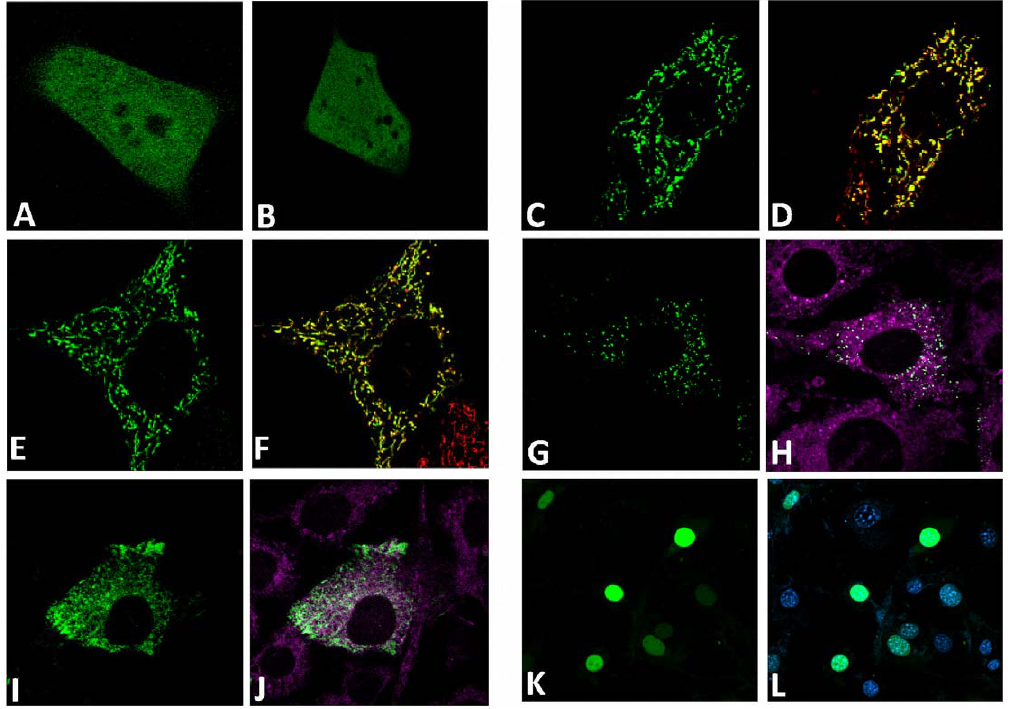
Figure 2. Intracellular localization of HyPer targeted to different cellular compartments in NIH 3T3 cells. Panels represent GFP (A) and HyPer expressed in the cytosol (B), mitochondria (C, D), mitochondrial IMS (E, F), peroxisomes (G, H), the ER (I, J), and the nucleus (K, L). Panels D, F are merged images with Mito-Tracker Red staining. Panels J, H show staining with ER-Tracker Blue, and L with Hoechst 34580. Arrows show mitochondrial IMS.